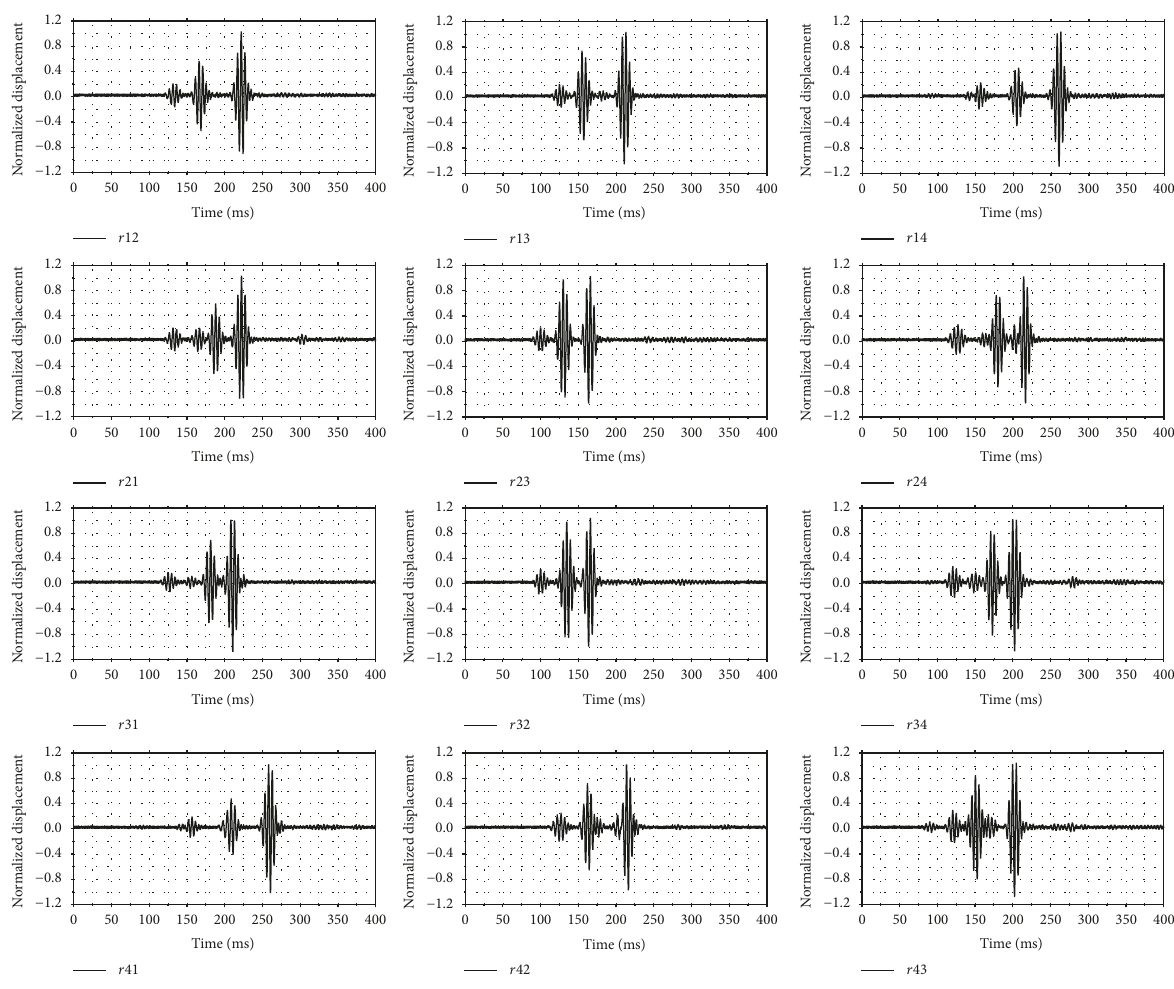
Figure 10: Residual signal of different transmitter-receiver pair (FE